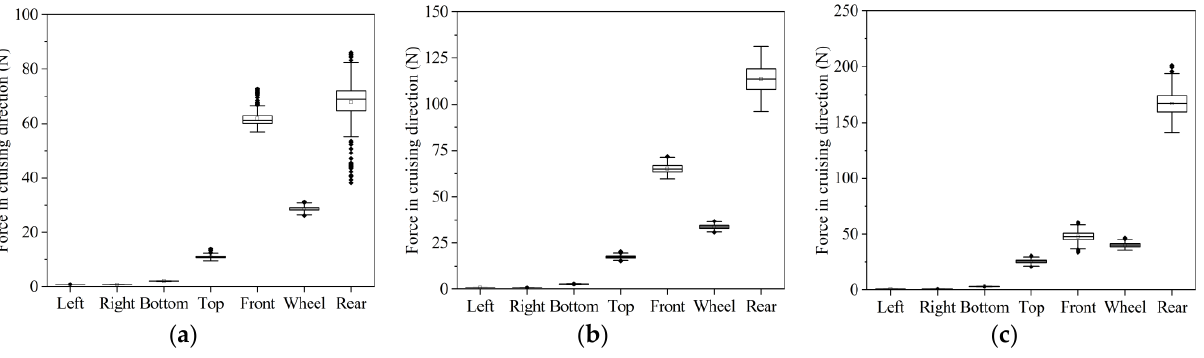
Figure 8. Asymmetric F X forces on the side of the bus at 20 km/h for ( a ) 1 m/s, ( b ) 1.5 m/s, ( c ) and 2 m/s side winds.